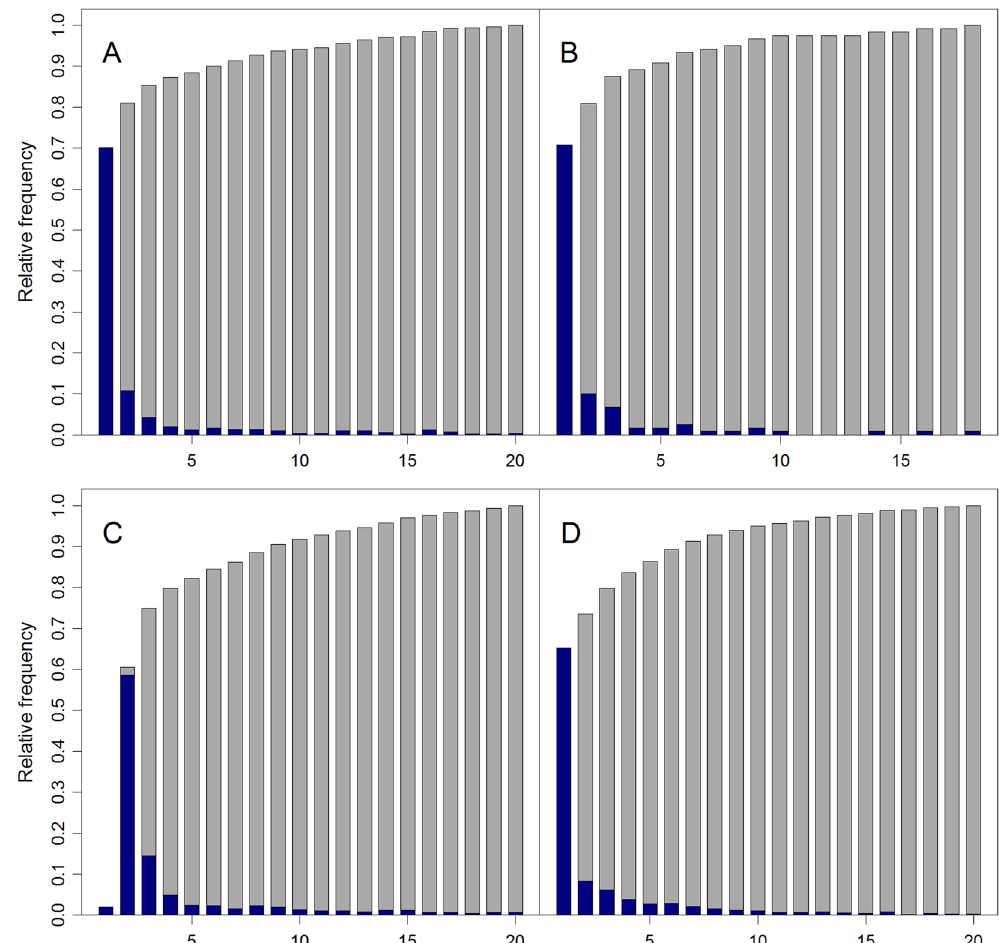
Figure 2. Rank histogram on simulation studies. Ranks of disease-causing indels against neutral indels, for different indel subtypes: ( A ) nonframeshift deletion; ( B ) nonframeshift insertion; ( C ) frameshift deletion; ( D ) frameshift